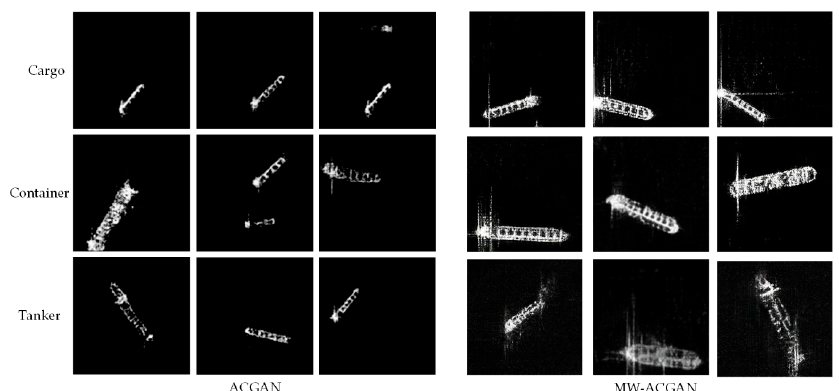
Figure 6. Comparison of ship slices generated by the ACGAN and the MW-ACGAN.